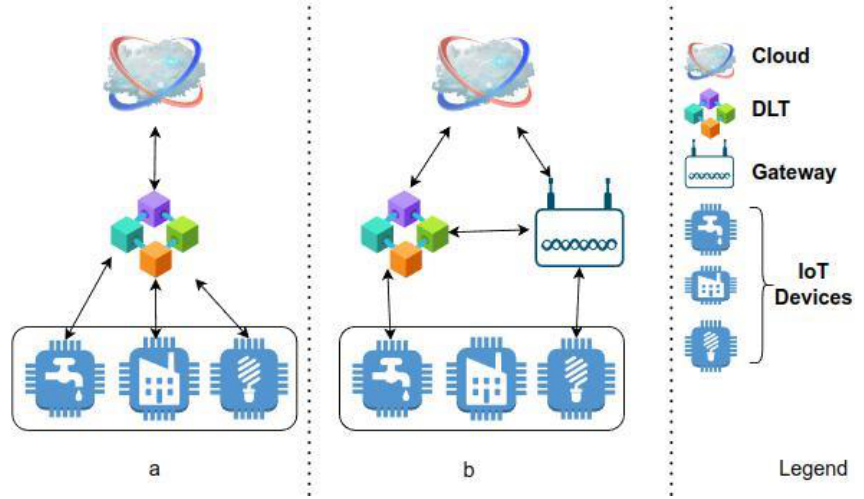
Figure 4. DLT and IoT Integration schemas ( a ) Without a Gateway Device, ( b ) With Gateway Device. In BigchainDB version 2.0.0 and later, each node has its own isolated local MongoDB database. Inter-node communications are performed using Tendermint protocols, not Mon- goDB protocols, as illustrated in Figure 5 below. If a node’s local MongoDB database gets compromised, none of the other MongoDB databases (in the other nodes) will be affected.